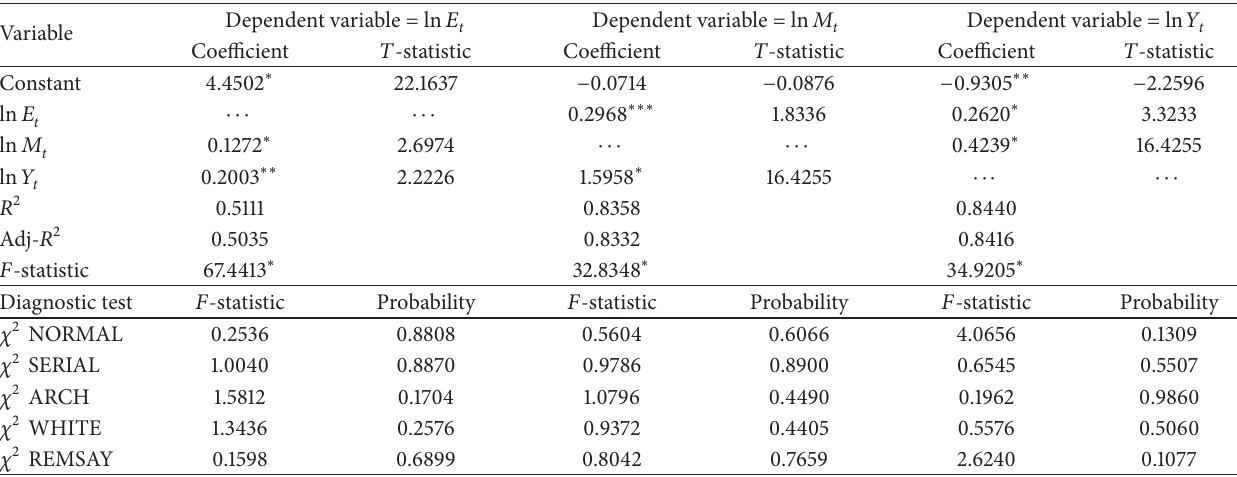
Table 6: Long run results.